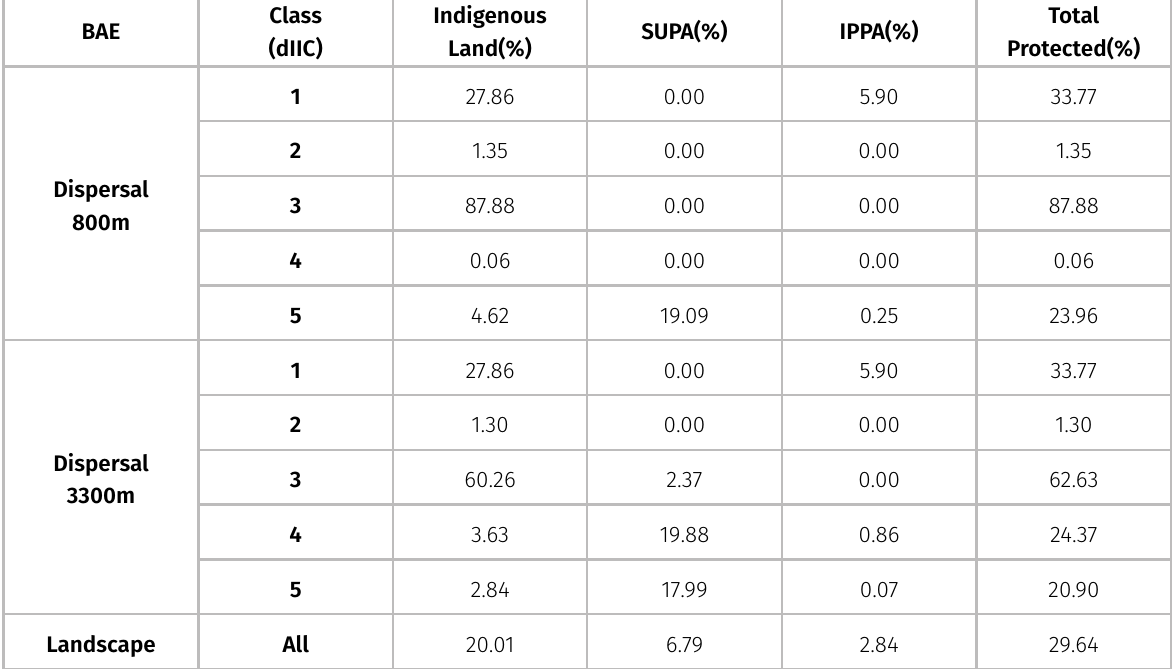
Table II. Proportion of the protected areas based on their importance on the connectivity index. SUPA – Sustainable Use Protected Areas; IPPA – Integral Protection Protected Areas ; BAE – Belém Area of Endemism. Class Indigenous BAE SUPA(%) IPPA(%) (dIIC) Land(%)